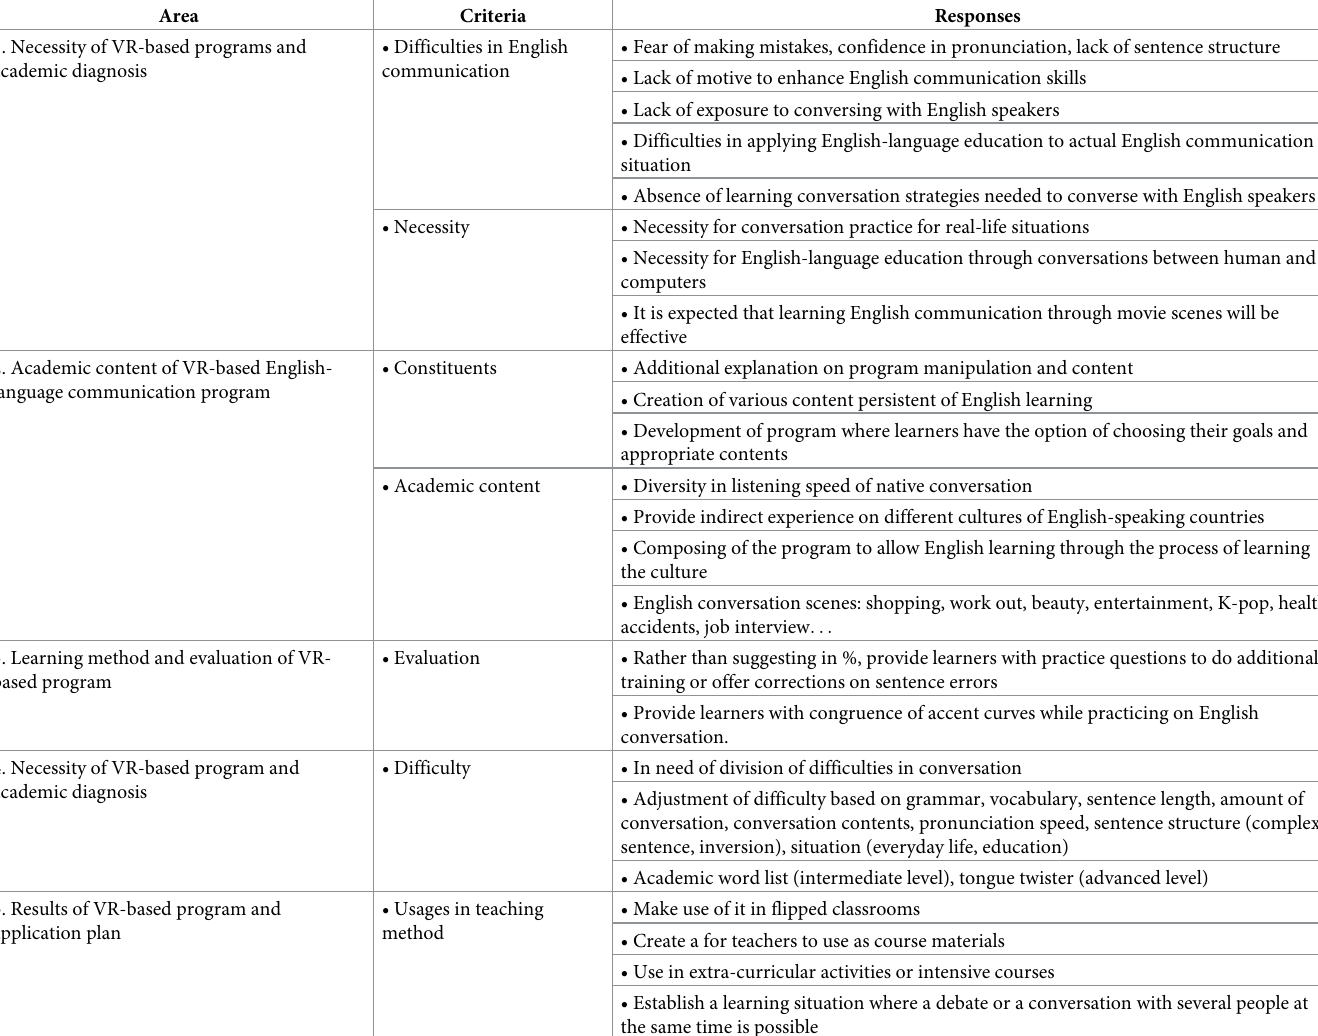
Table 4. Overview of responses from MCQs and OEQs from first Delphi survey.